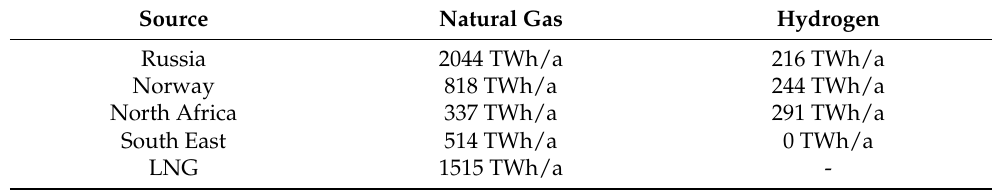
Table 6. Import potentials in Europe (modified based on